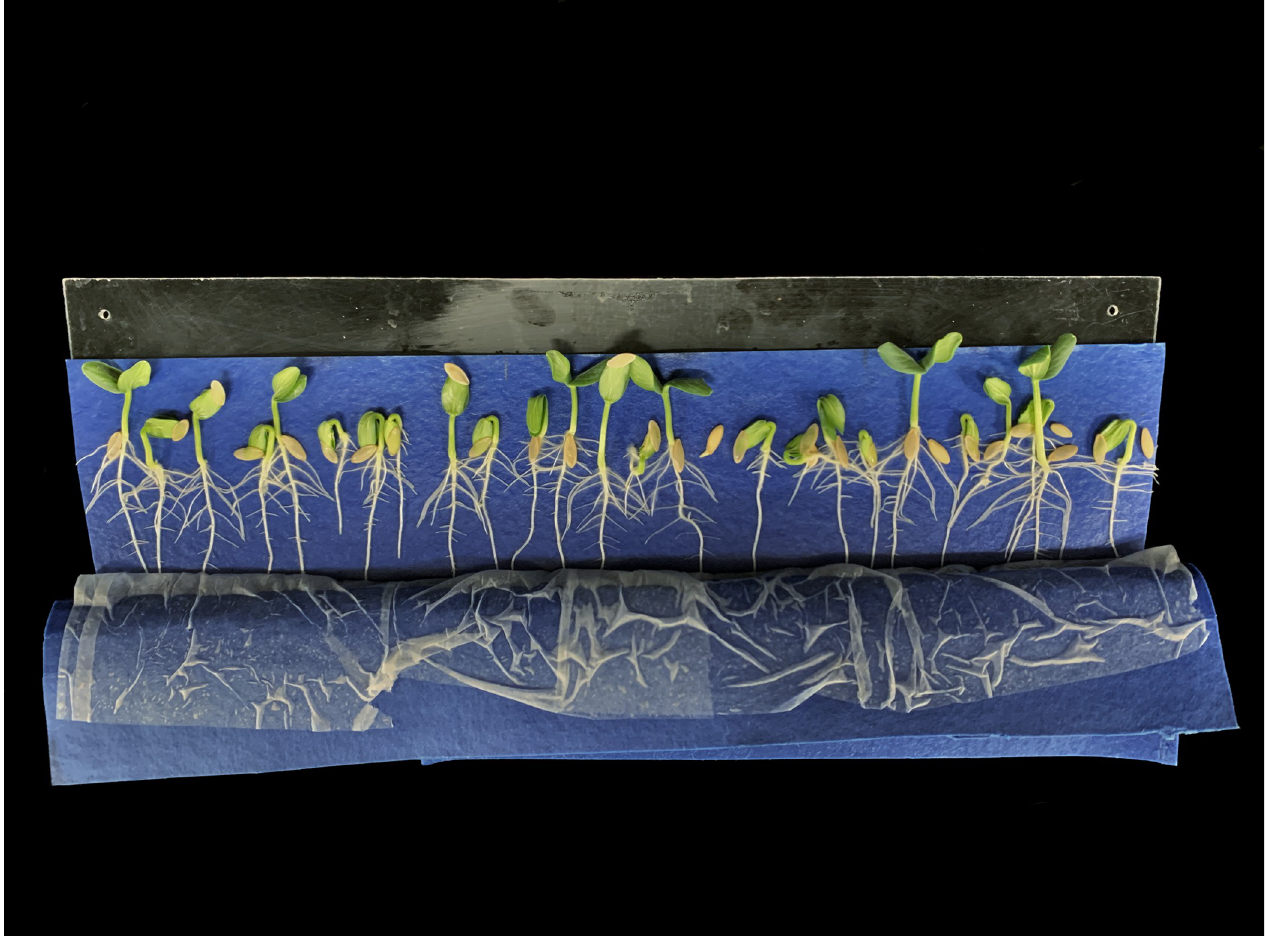
Fig 7. Cucumber seedlings on a slant board with two layers of germination paper. The roots of cucumber seedlings branch more than other species such as lettuce and tomato.